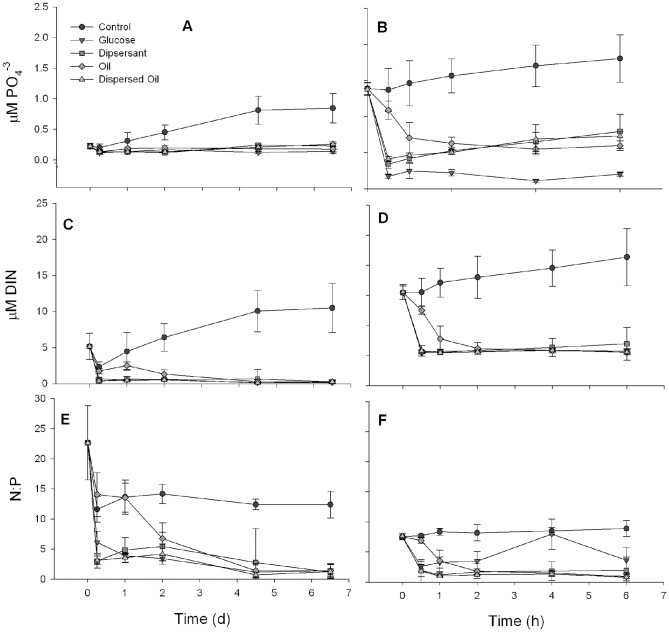
Concentration of PO4
−3 (A, B), total DIN (NO2
−+NO3
−+NH4
+, C, D) and N∶P (E, F).June (A, C and E) and August (B, D and F) showed similar patterns even though the starting conditions were different. Error bars are standard deviations of the means.